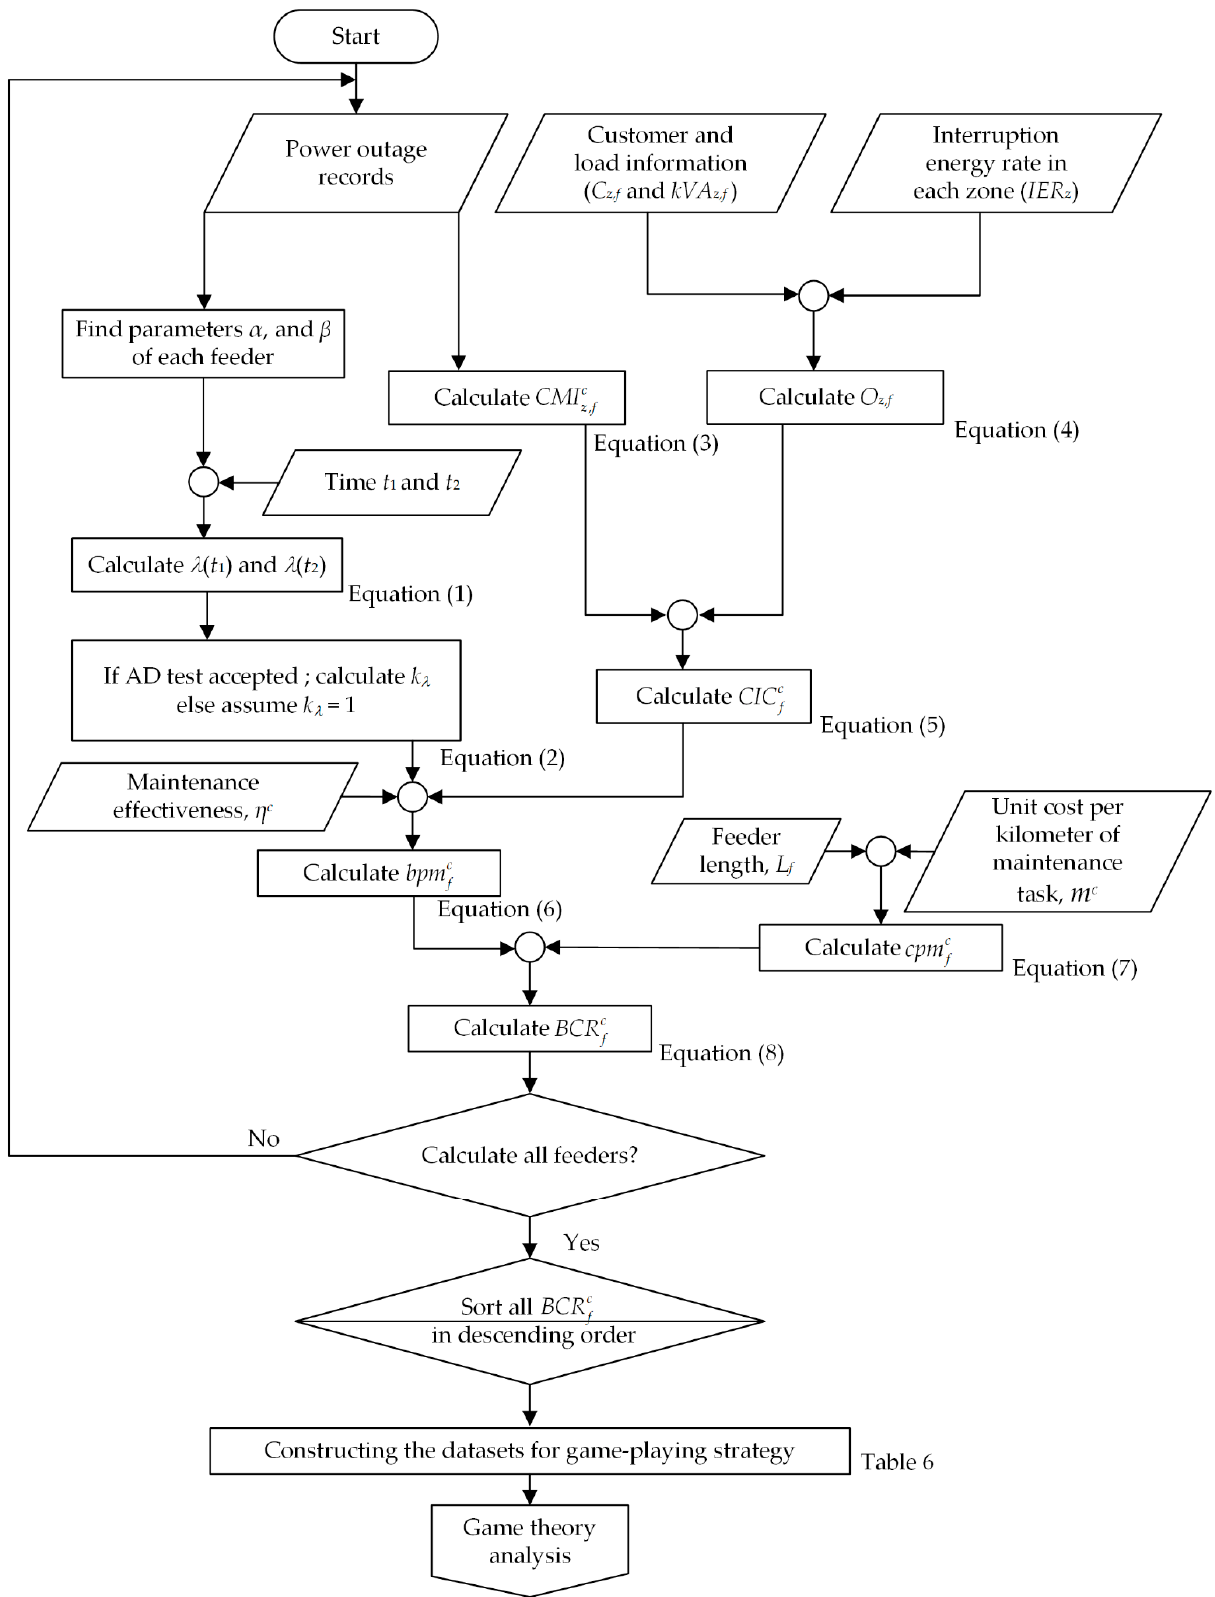
Figure 4. Flowchart for constructing the datasets for game-playing strategies.